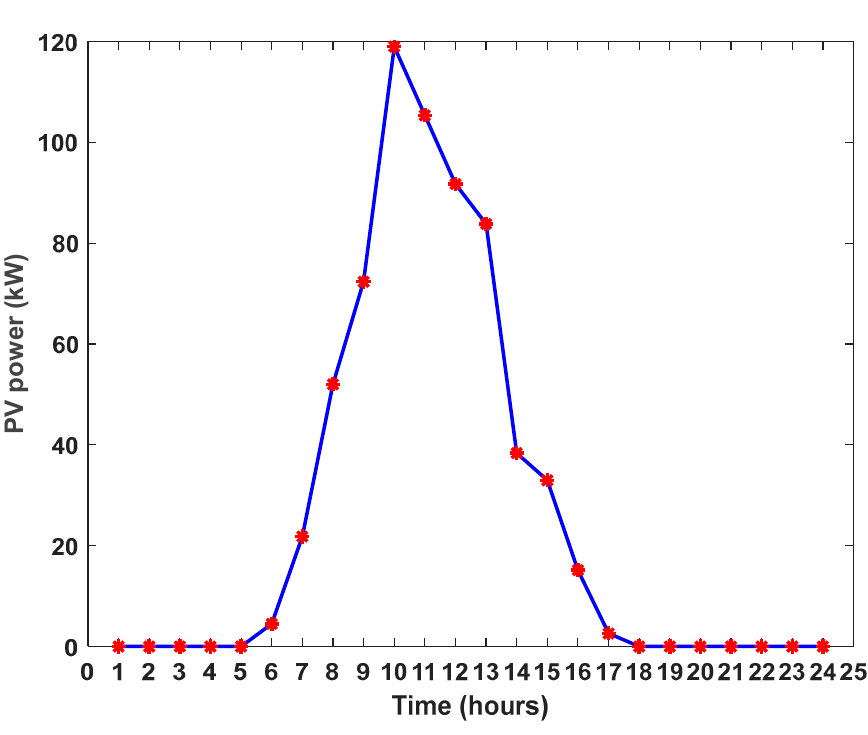
Figure 7. PV power produced profile for the month of March.